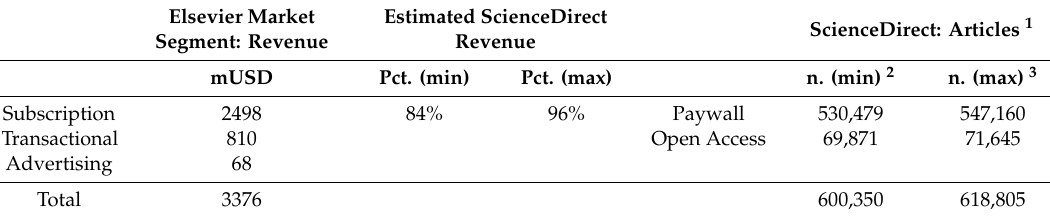
Table 2. Summary of the key figures concerning Elsevier’s market segment and ScienceDirect